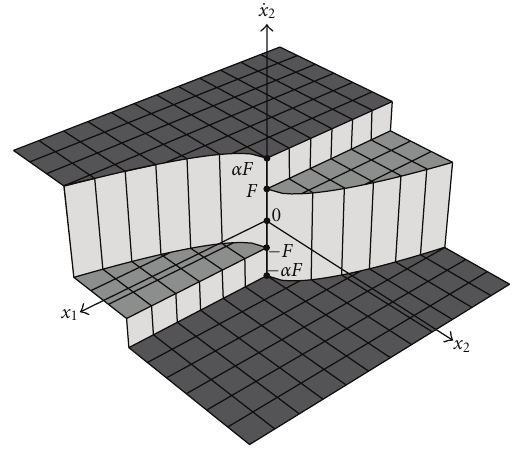
Figure 1: Relation among x 1 , x 2 , ˙ x 2 , and α .